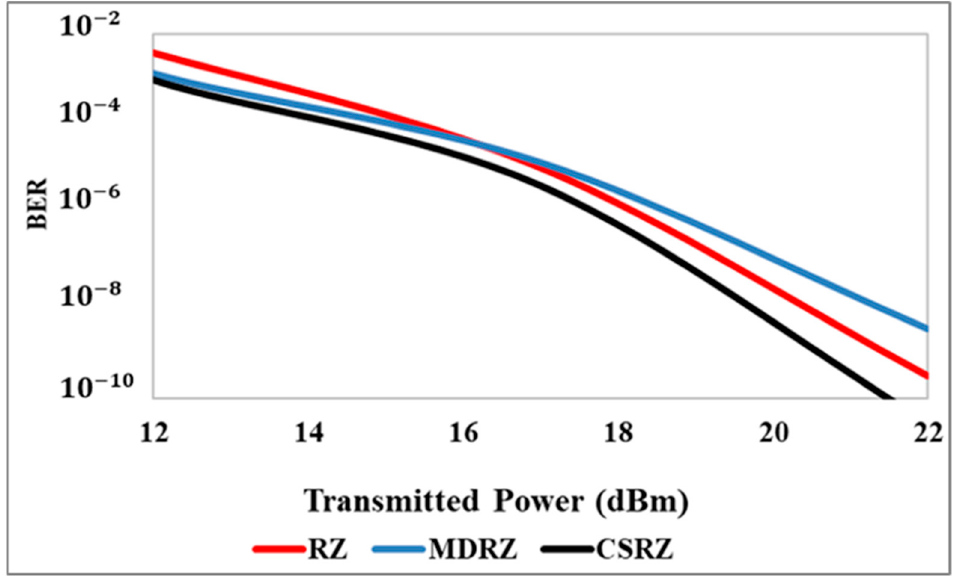
Figure 4. The Average BERs versus Transmitted Power for Four Random Channels (RZ).